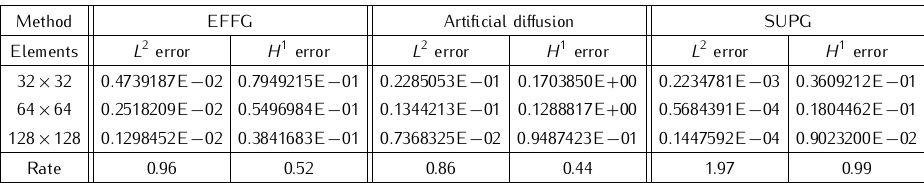
Table 5. Comparison of the L 2 -norm and H 1 -seminorm convergence rates of the exponentially fitted flux (EFF) method (18), the classical artificial diffusion, and the SUPG method, for ε = 0 . 00001 and the velocity field from Example